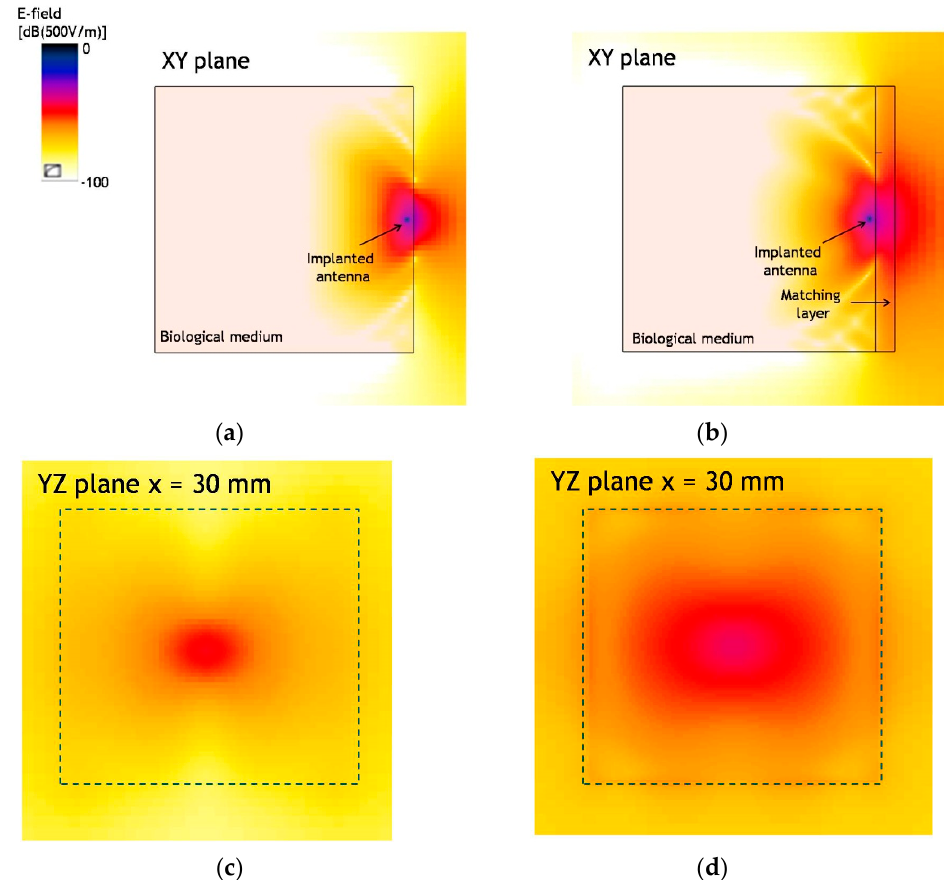
Figure 9. The E-field distribution: XY plane without ( a ) and with matching layer ( b ); YZ plane without ( c ) and with ( d ) matching layer.